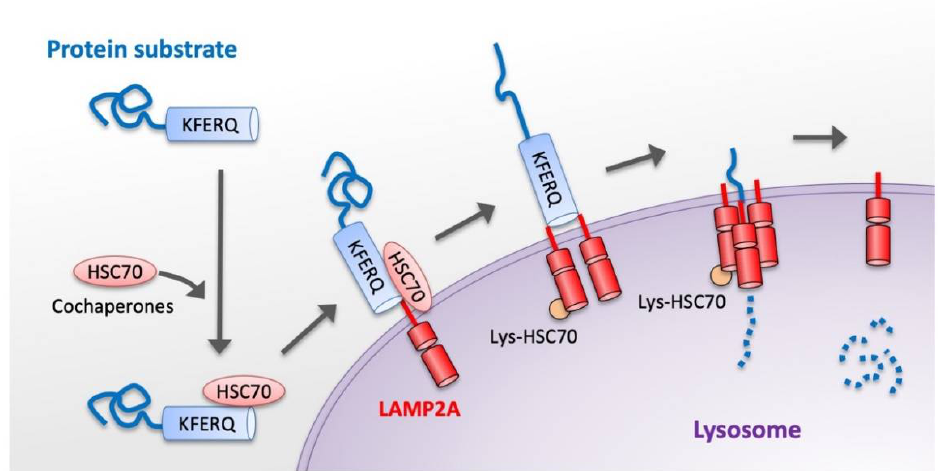
Figure 1. Process of protein degradation via chaperone-mediated autophagy. The KFERQ-like motif of the protein substrate is recognized by Hsc70 and its cochaperones. This complex binds lysosome-associated membrane protein type 2A (LAMP-2A). LAMP2A monomers are assembled into multimeric structures, forming the translocation complex. The substrate proteins are then unfolded and translocated through the lysosomal membrane, assisted by lysosomal Hsc70 (Lys-Hsc70). Finally, the protein is rapidly degraded within the lysosome and then the translocation complex is disassembled.